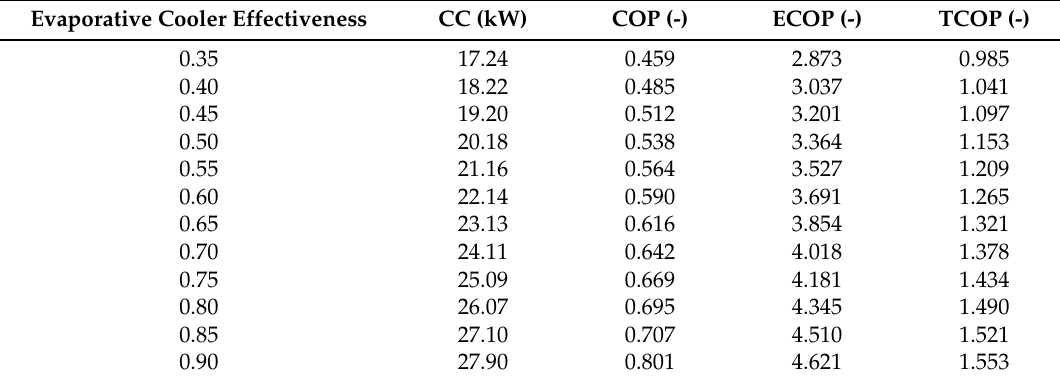
Table 4. Effect of evaporative cooler effectiveness on the system performance.